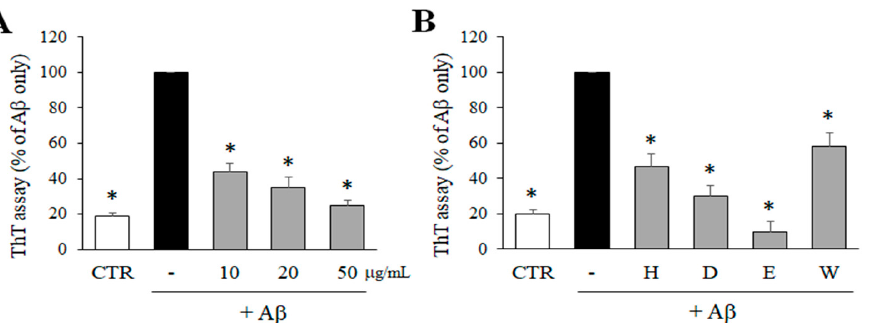
Figure 1. E ffects of the ethanol extract and solvent-partitioned fractions on A β aggregation. ( A ) A β